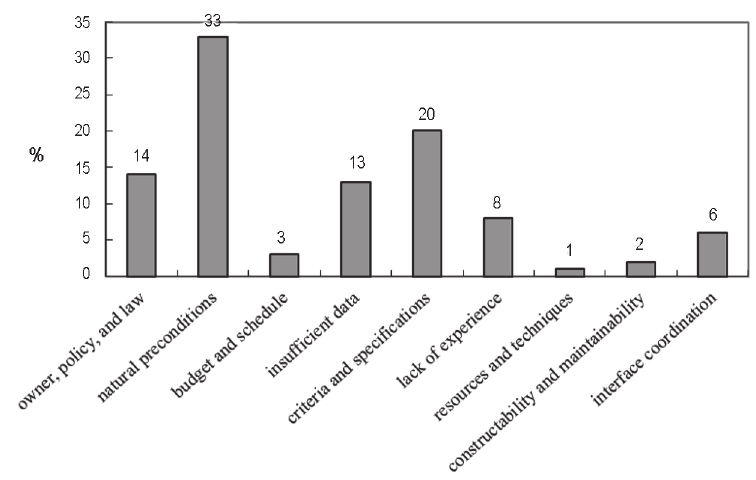
Fig. 3. Proportions of difficulty reasons in sustainable roadway